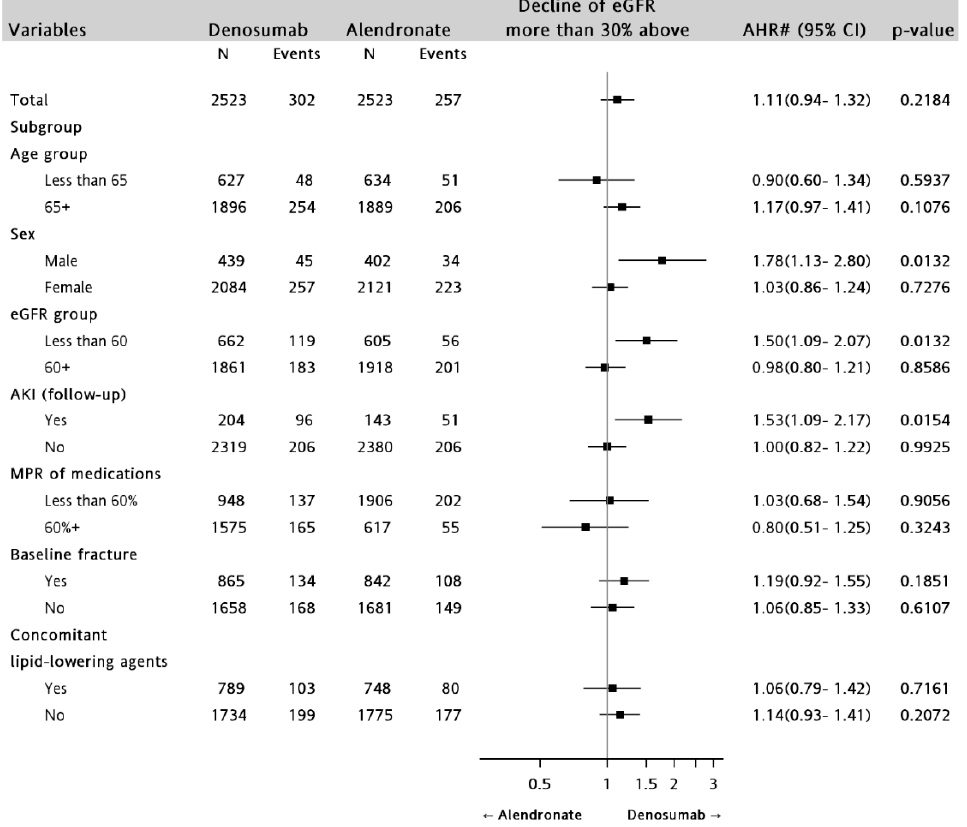
Figure 4. Stratified analyses of the risk of eGFR decline ≥ 30% between the denosumab and alendronate groups (denosumab versus alendronate). AKI: acute kidney injury; AHR: adjusted hazard ratio; eGFR: estimated glomerular filtration rate; MPR: medication possession rate. # Adjusted for age group, sex, baseline eGFR group, mean dose of drug, CVD-related comorbidities, baseline comorbidities (abnormal thyroid function, obstructive sleep apnea, and fracture), concomitant medications (anti-thrombotic agents, lipid-lowering agents, antidiabetics, antihypertensive agents, and other osteoporosis therapy).